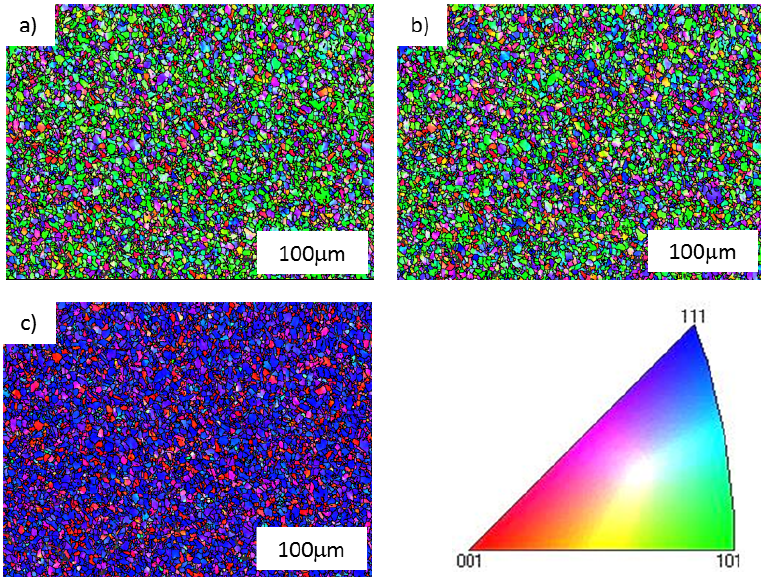
Figure 10. Inverse pole figure maps in the ( a ) X direction; ( b ) Y direction and ( c ) Z direction. Orientation colour key indicated.